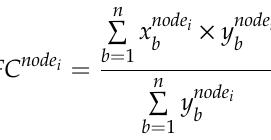
Figure A3. The De-Blurring control result for high membership function in the CMFI system.